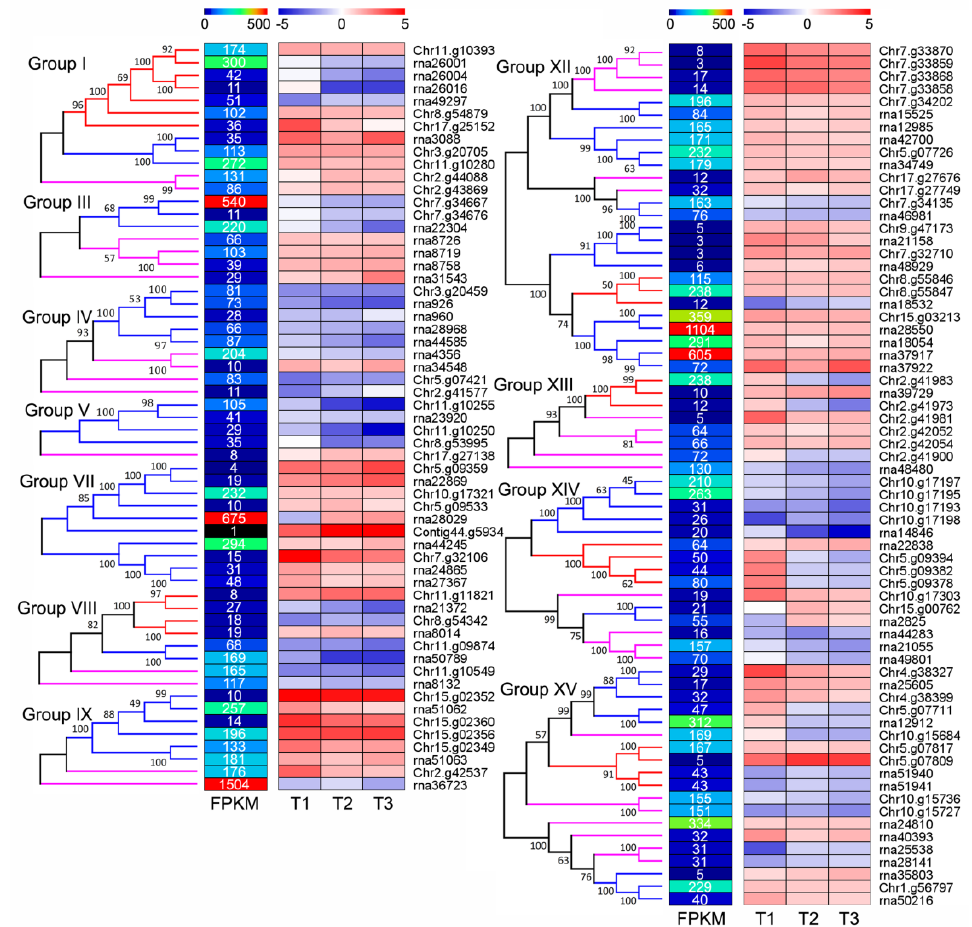
Figure 6. The amount of NLR was differentially expressed during ‘Yuluxiang’ ( P. bretschneideri , susceptible pear variety) and ‘Duli − G03’ ( P. betulifolia , resistant pear rootstock) respond to signals from Valsa pyri ( Vp ). The trees were contructed based on amoino acid sequences. 3.7. NLRs Take a Crucial Role in ‘Duli-G03’ Response to Vm Signals We screened a total of 18,931 DEGs from two ‘Duli-G03’ RNA-seq datas under Vp or Vp M treatment and performed co-expression network analysis. All related genes were screened according to a reliability threshold (weight > 0.5) and annotated for NLR genes among them. Further, we constructed a co-expression network for NLR genes. Notably, 13 genes are distributed on the key nodes of the network (Figure 7). Among these, four members are located at the most central position and are likely to play an im- portant role in the regulation of the Valsa canker, including two genes from GroupVII ( Chr3.g19943 and Chr7.g32106 ), one gene from GroupIX ( Chr2.g42537 ) and one from GroupXII ( Chr5.g07640 ). Besides, we also discovered nine genes from other NLR groups, including GroupI ( Chr7.g34568 and Chr7.g34388 ), GroupXIII ( Chr2.g41974 and Chr2.g41981 ), GroupXIV ( Chr10.g17303 , Chr5.g0938 8, and Chr5.g09378 ) and GroupXV ( Chr10.g15727 and Chr4.g38327 ), which are co-expressed with multiple genes. The above genes probably take a crucial part in ‘Duli-G03’ in response to Vp signals and could be considered as candidates for further functional